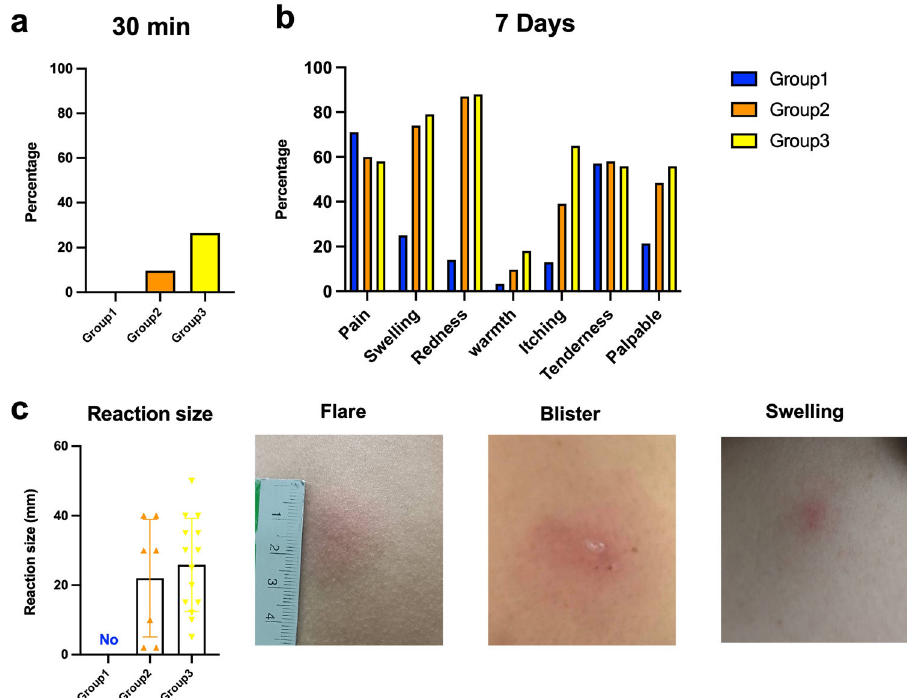
Fig. 2 Solicited local adverse reactions at 30 min and 7 days after boosting. Full dose of intramuscular (Group 1, blue) and one in fi ve doses of intradermal viral vector vaccines were given 4 – 8 weeks after completed vaccination with two doses of inactivated SARS-CoV-2 (Group2, orange). Some of the vaccinated individuals were boosted with a fractional dose of intradermal viral vector 8 – 12 weeks after completing two doses of the inactivated vaccine (Group3, yellow). a The immediate local reactions were observed within 30 min after injection. b Seven days after boosting, local adverse events were recorded to compare between booster groups. c The margins of local reaction size were measured and recorded as millimetres interval of 4 – 8 weeks ( p = 0.0003 and p = 0.0126 respectively, Fig. 6d). The TNF- α responses were also observed in CD8 + T cells (Fig. 6e, f). After 28 days of a booster, the TNF- α production of CD8 + T cells followed the same trend with the IFN- γ responses but the differences were not statistically signi fi cant (Fig. 6f).